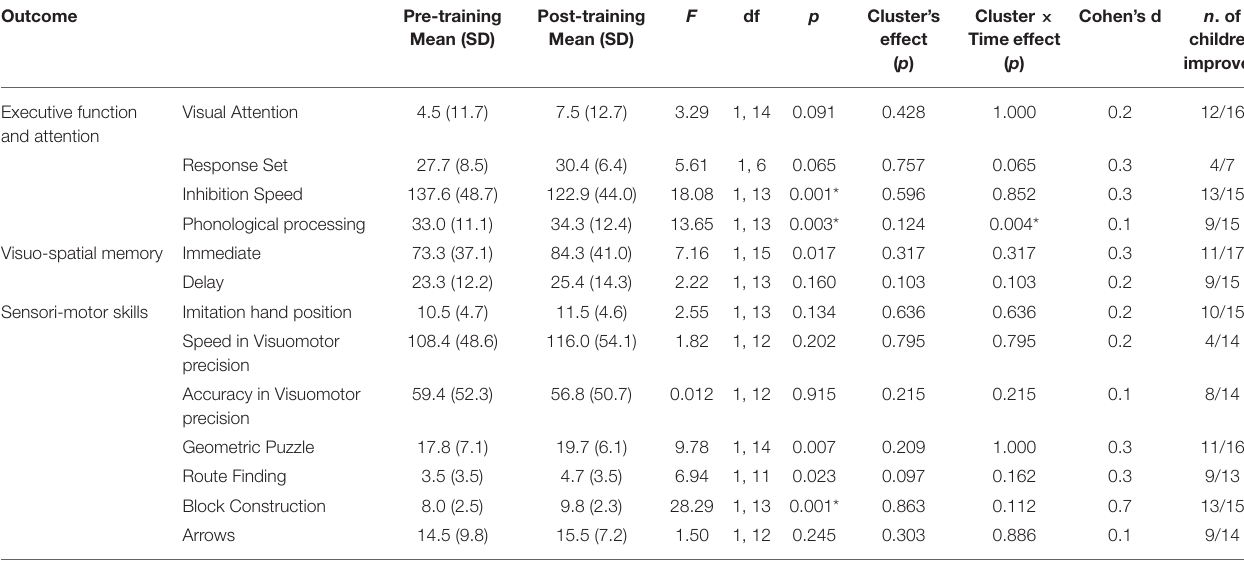
TABLE 3 | Comparison between pre- and post- training performance at single subtests.